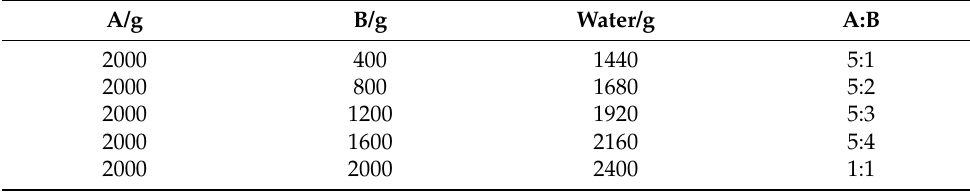
Figure 2. The test molds. ( a ) Prism stone mold ( b ) Cylinder stone mold.